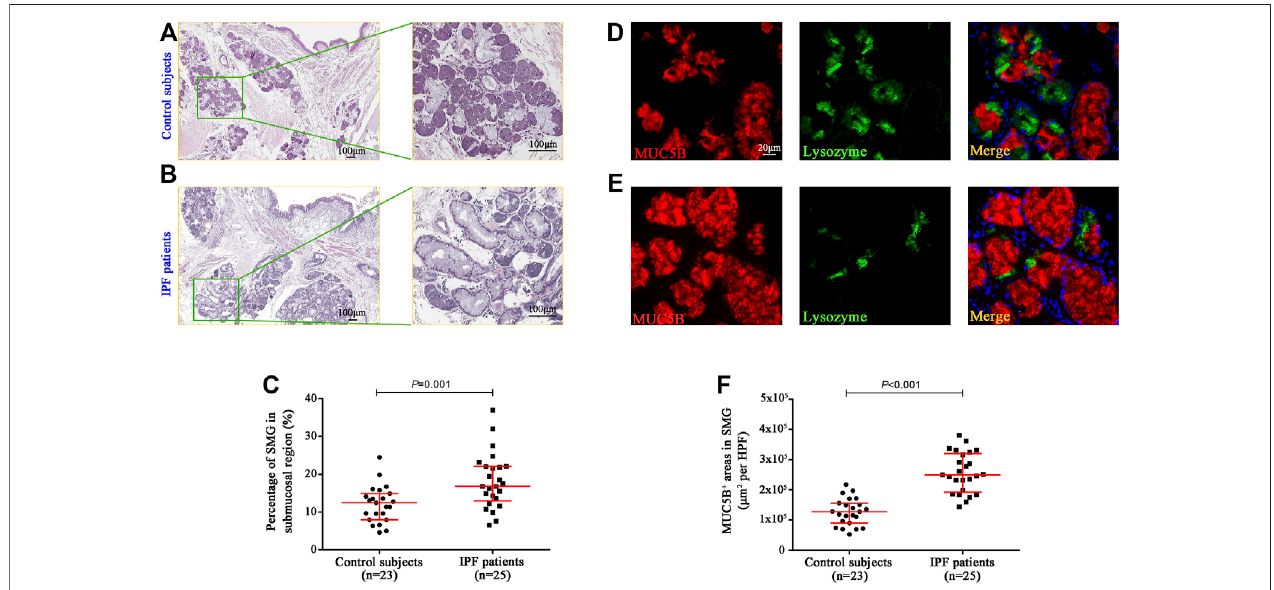
FIGURE 1 | Quanti fi cation of glands and MUC5B expression in bronchial submucosal region. Representative H&E staining images in the bronchi from control subjects (A) and IPF patients (B) , and the median SMG area (expressed as the proportion of SMG region over the total mucosal region) was signi fi cantly higher in IPF patientsthanthatincontrolsubjects (C) .TheIFstainingshowsthatthemedianareasofmucuscomponent(MUC5B-positive)inSMGsweresigni fi cantlyincreasedinIPF patients compared to those in control subjects (D – F) . DAPI labeling of nuclei (blue). DAPI, 4 ′ ,6-diamidino-2-phenylindole; H&E, hematoxylin and eosin; MUC5B, mucin 5B; SMG, submucosal glands; IF, immuno fl uorescence; IPF, idiopathic pulmonary fi brosis.